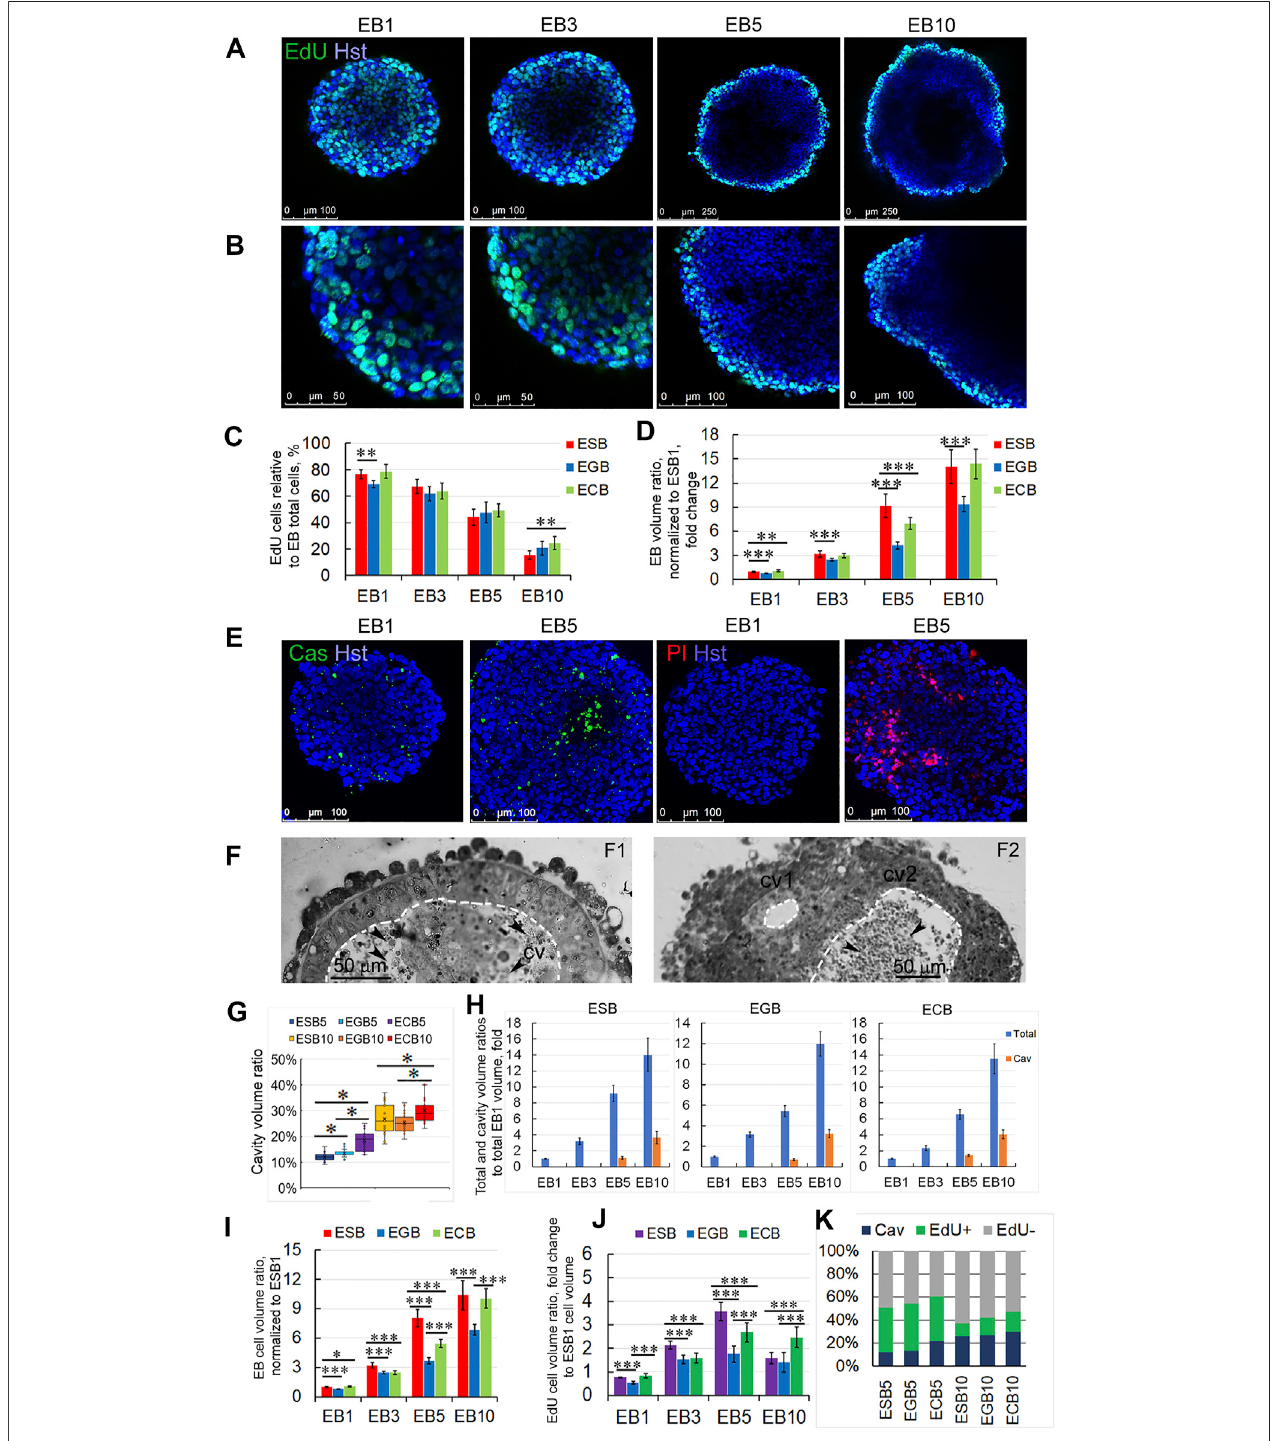
FIGURE2| SpatiotemporalgrowthdynamicsofESB,EGBs,andECBs. (A,B) Representativeimmuno fl uorescenceconfocalimagesofEdU-labeledcellsinEBsat EB1, EB3, EB5, and EB10 stages. (B) Higher magni fi cation images of A images. Nuclei were stained with Hoechst 33342 (Hst). The spatial distribution of EdU-labeled cells in EBs changes from uniform to surface during differentiation. (C) Proportions of the EdU-labeled cells to total cell numbers (Hst) in differentiating ESB, EGBs, and ECBs were counted using the ImageJ/Fiji cell counting tool ( n = 7 × 4 stages for each cell line; total N = 84). The data are presented as means ± s.d., ** p < 0.01 , ANOVA. (D) EBvolumegrowthdynamicssigni fi cantlydifferedbetweenESB,EGBs,andECBs(24EBs/perstage;threeexperiments;N=288foreachcellline).TotalEB volumesatallstageswerenormalizedtoESB1volume. (E) Representativeimmuno fl uorescenceconfocalimagesofcaspaseactivity(Cas),PI-stained necroticcells,and